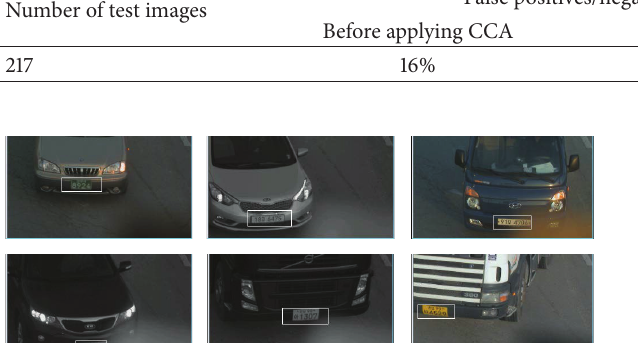
Figure 18: Successful images for LPD using our proposed method under different rotation and